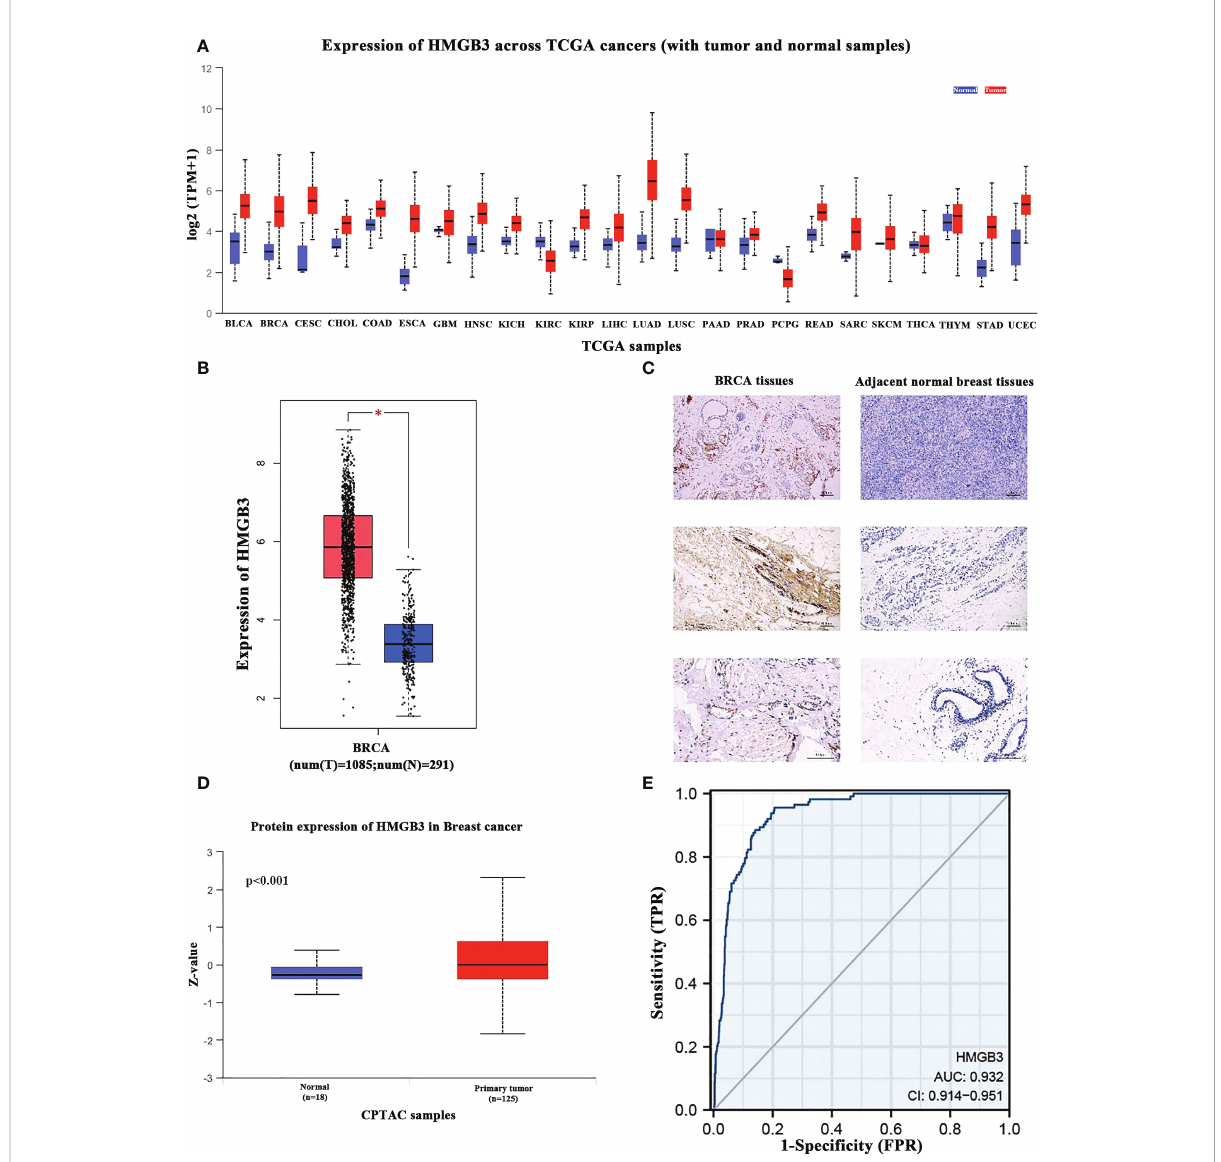
FIGURE 1 HMGB3 expression levels in various cancer types. (A) UALCAN database was used to analyze the levels of HMGB3 expression in various types of cancer tissues and their matched normal tissues. (B) Breast cancer tissues have higher levels of HMGB3 than normal tissues, according to Gene Expression Pro fi ling Interaction Analysis (GEPIA); *p<0.05. (C) HMGB3 immunohistochemical staining of BRCA tissues and adjacent normal breast tissues. Brown indicates the intensity of the expressed protein. (D) The presence of the HMGB3 protein in breast cancer. (E) Receiver operating characteristic curve of HMGB3 in BRCA. False-positive rates are represented on the X-axis, and true-positive rates are represented on the